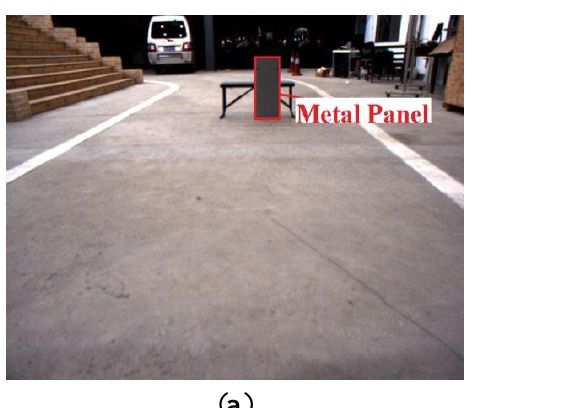
Figure 4. ( a ) Experimental image for radar-vision point alignment; ( b ) the corresponding radar detection